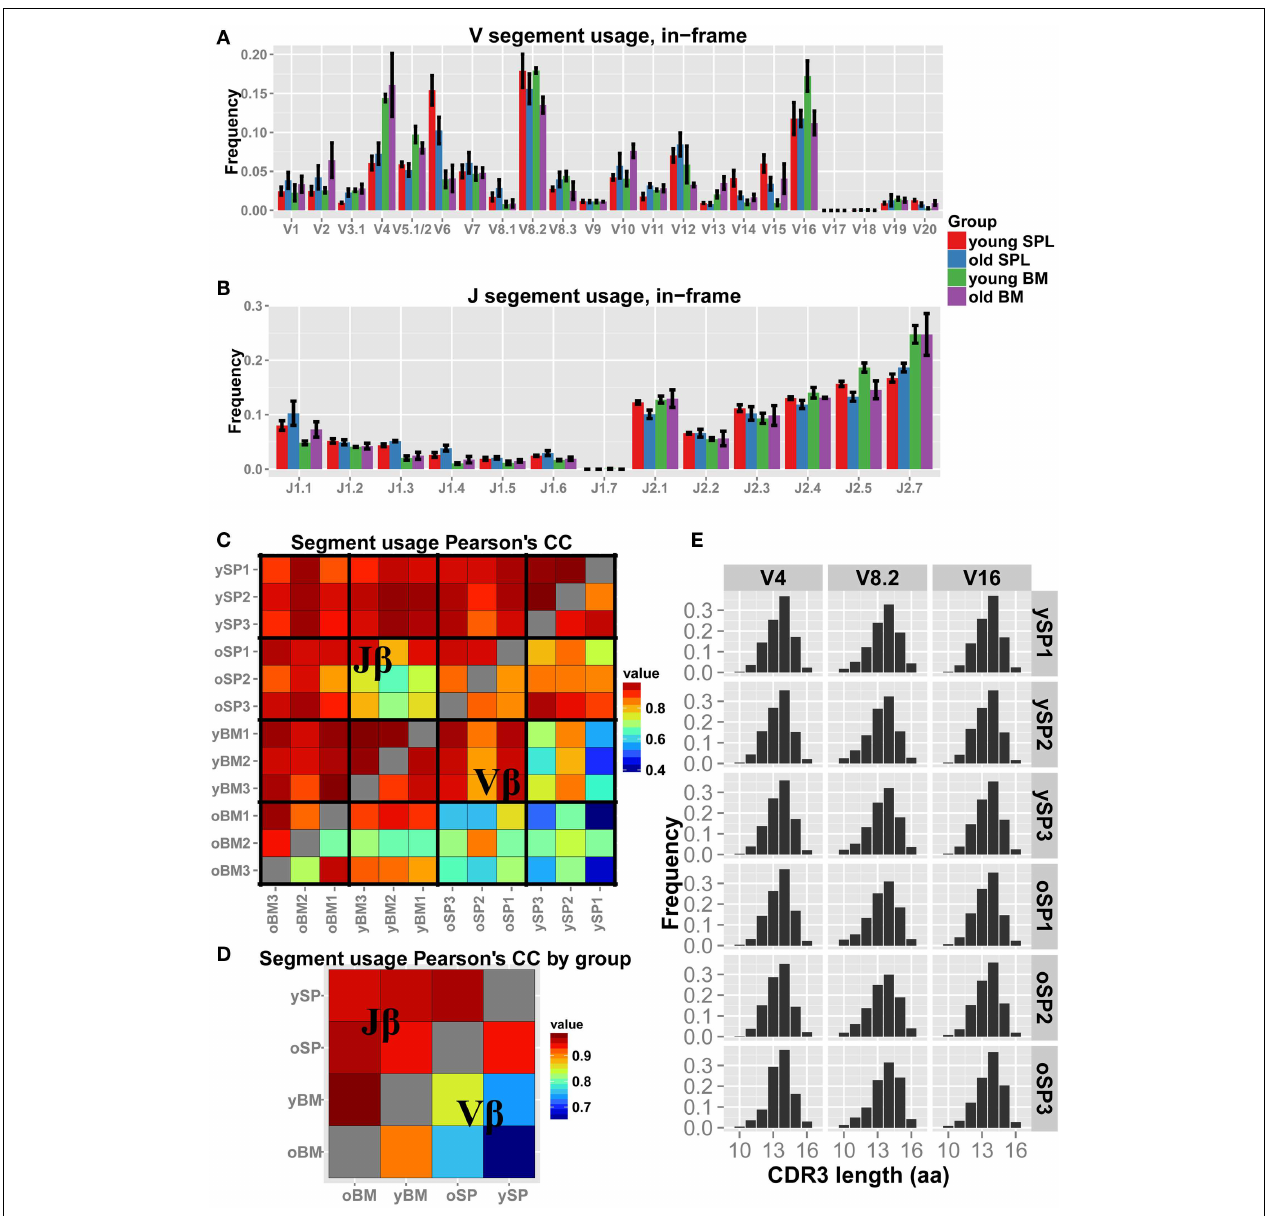
high correlation in the data, with inter-tissue similarity across age groups. BM = bone marrow, SPL = spleen, n = 3 for all groups. (E) “Virtual” spectratypes. Each bar represents the relative frequency of a particular CDR3 length (in amino acids) for three representativeV β segments, stated above each panel, measured across individual SPL samples. No significant changes could be detected in CDR3 length distributions across age